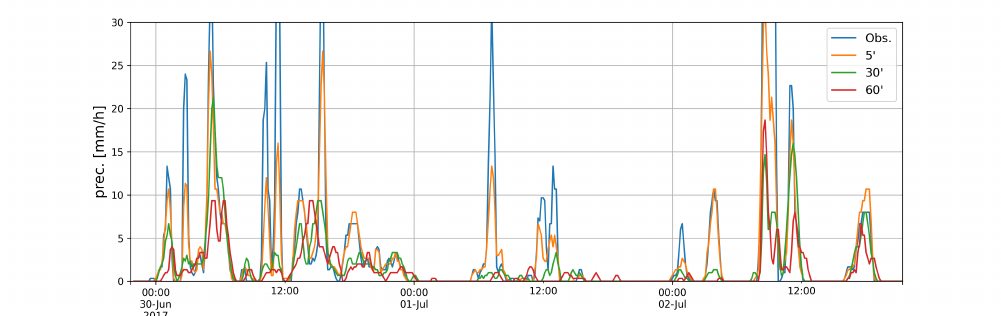
Figure 10. Power spectral density averaged over all the precipitation events of 2017, for times of forecast of 5’, 30’ and 60’ on boxes ( a ), ( b ) and ( c ) respectively.